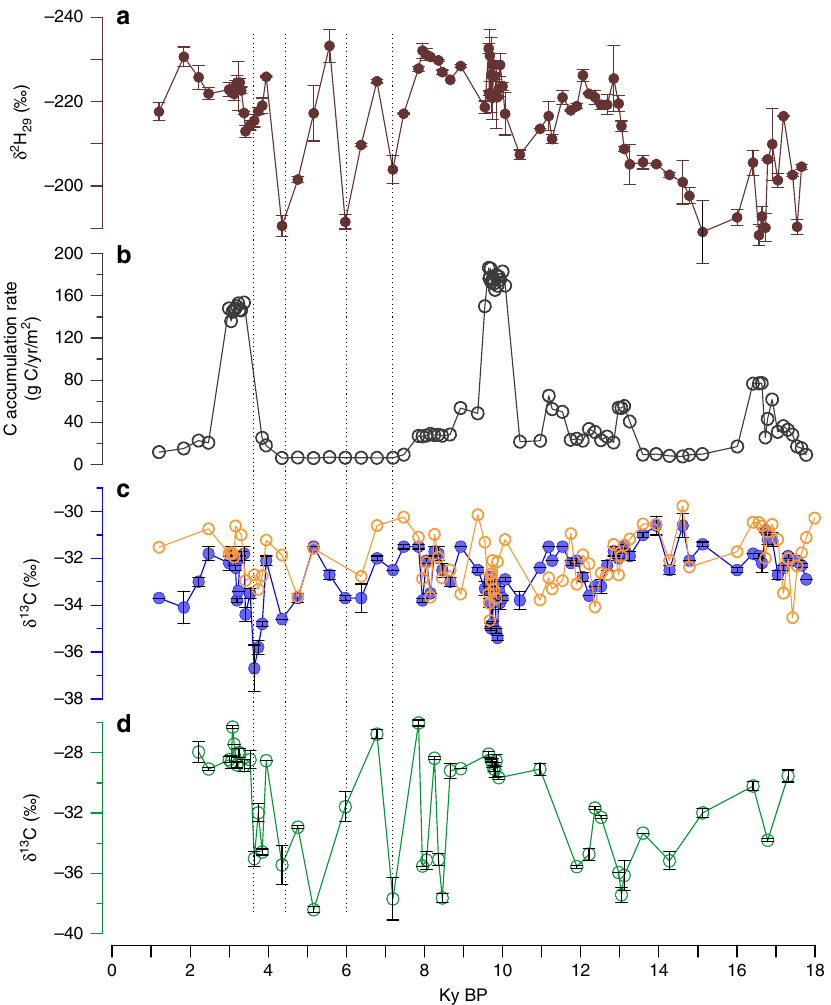
Fig. 5 Comparisons of paleohydrological and carbon-related records in ZK-5 core. a δ 2 H 29 values. b Carbon accumulation rate. c The δ 13 C values of C 23 (un fi lled circle) and C 29 n -alkane ( fi lled circle). d C 29 ββ hopane. Error bars represent 1 s.d. of replicate runs. The dashed vertical lines infer the drier